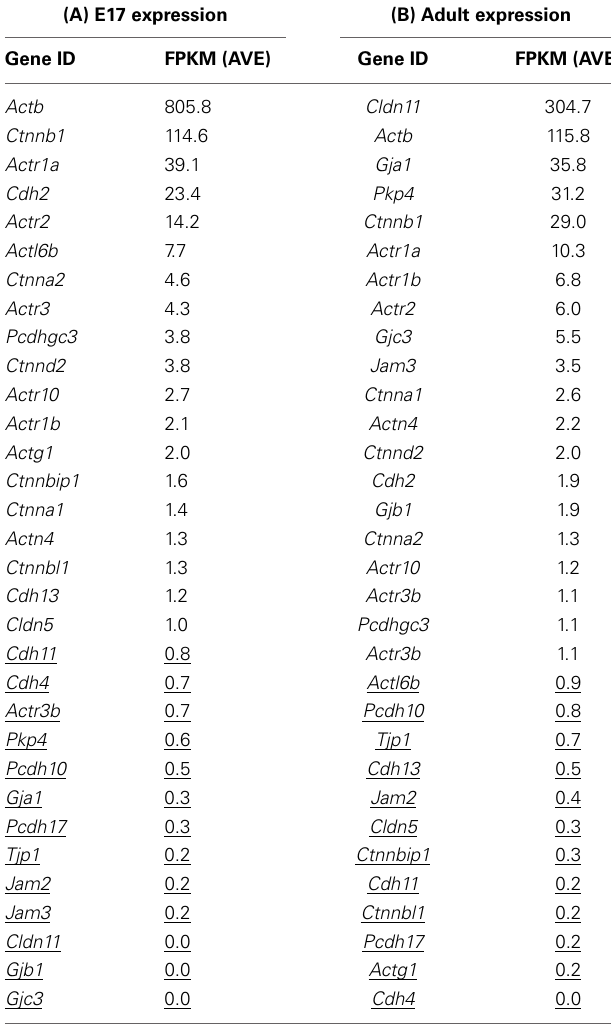
Data are average FPKM (fragments per kilobase of exon per million fragments mapped) from three independent pooled samples of ventricular zone from embryonic day 17 (E17) and adult rats. Genes with FPKM expression < 1.0 were considered not expressed (underlined in